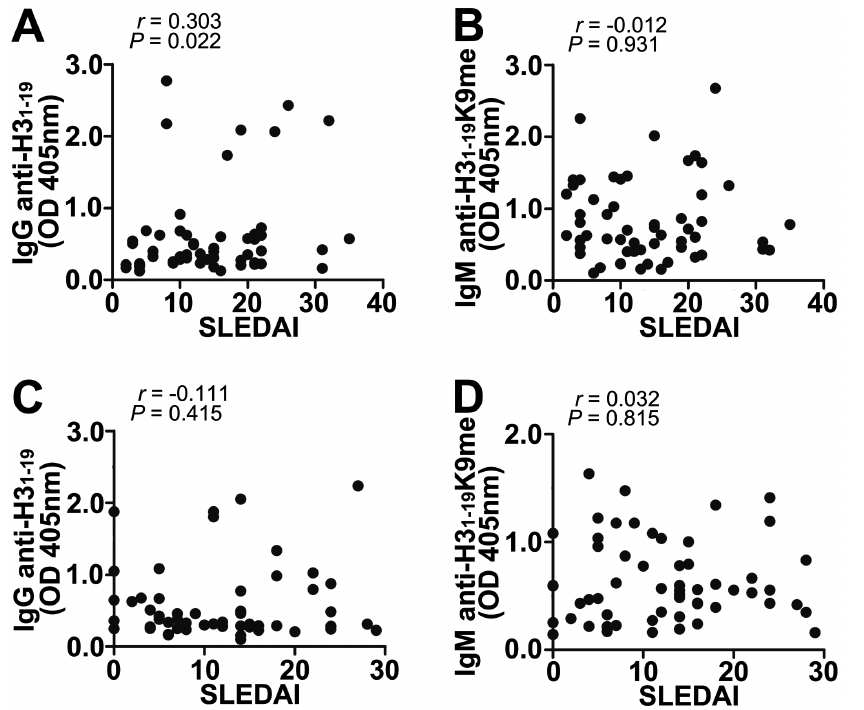
Figure 10. Correlations between SLEDAI scores and levels of IgG anti-H3 1 – 19 , IgM anti-H3 1 – 19 K9me. (A) Correlation between IgG anti- H3 1–19 and SLEDAI of pSLE. (B) Correlation between IgM anti-H3 1–19 K9me and SLEDAI of pSLE. (C) Correlation between IgG anti-H3 1–19 and SLEDAI of aSLE. (D) Correlation between IgM anti-H3 1–19 K9me and SLEDAI of aSLE. The correlations were analyzed by Pearson correlation analysis. pSLE: n=57, male/female=11/46, age 10.87 6 2.95 yrs old; aSLE: n=54, male/female=10/44, age 33.00 6 11.00 yrs old.